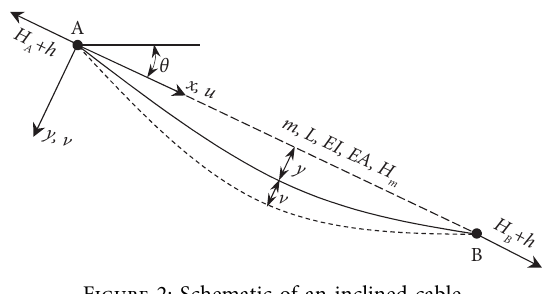
Figure 3: Schematic of a discretized inclined